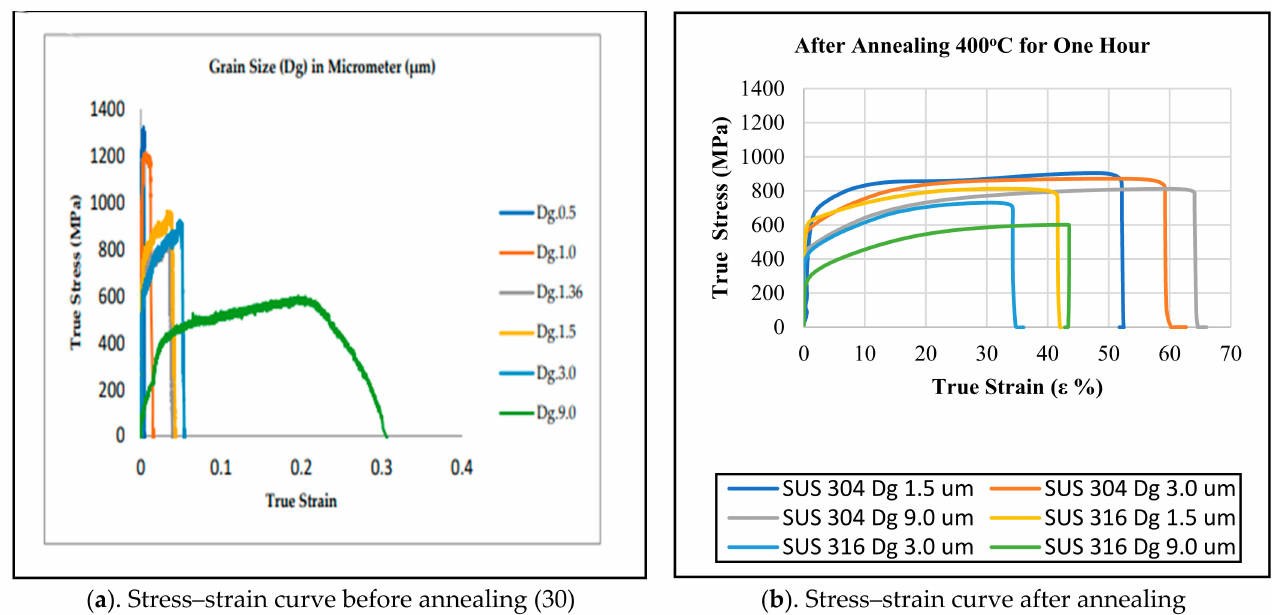
Figure 3. Stress–strain curve of SUS 304 and SUS 316 thin foil before ( a ) and after annealing ( b ). Figure 4 indicates the relation between the surface roughness and true strain at a low strain level of 5% (1.0% at one stage of the tensile test) and at a high strain level of 25% (5.0% at one stage). The samples of both SUS 304 and SUS 316 thin metal foils were subjected to five stages of a tensile test at low strain and high strain levels. Thus, the accumulation of the strain level for low strain was 5.0%, and the accumulation of the strain level for high strain was 25.0%.